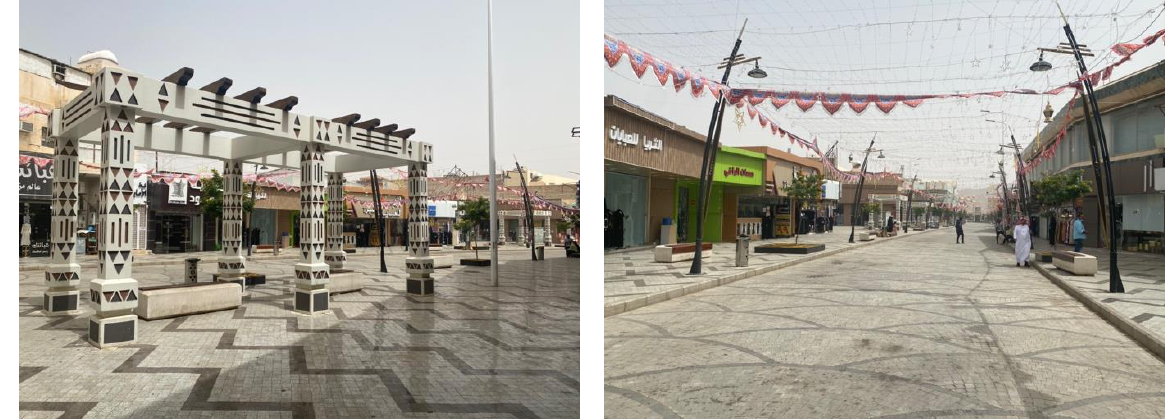
Figure 15. Barzan marketplace main street during mid-afternoon. Source: Authors.